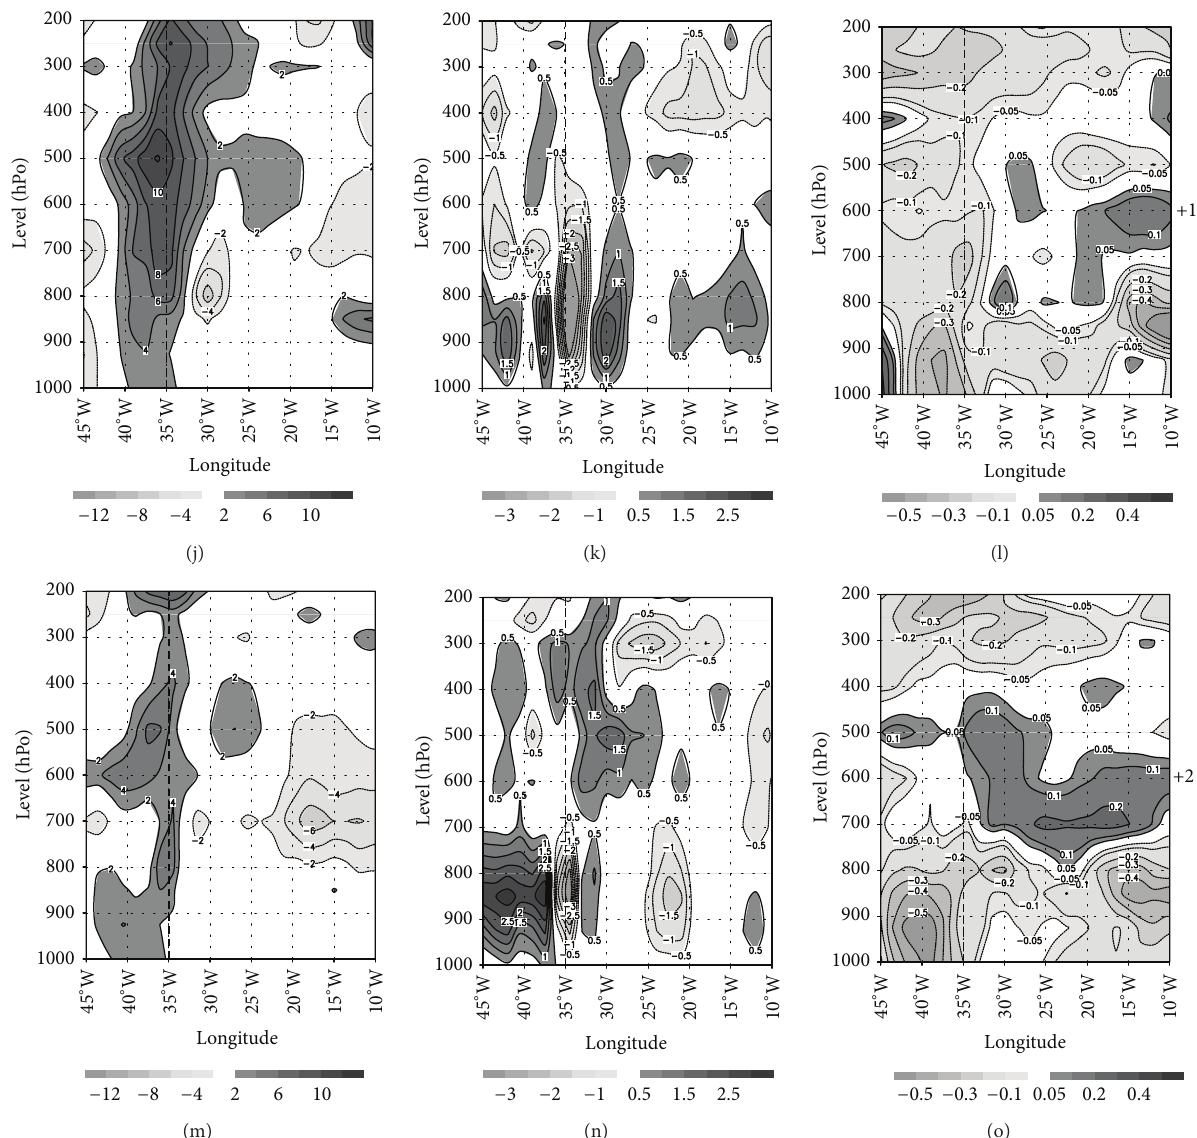
Figure 8: Vertical cross-section composite anomalies along 8 ∘ S of the relative humidity (%, left column), vertical velocity (m ⋅ s −1 , center column), and temperature ( ∘ C, right column) in the period from April to July 2007. The vertical dashed line at 35 ∘ W mark the subjectively estimated longitudinal position of littoral